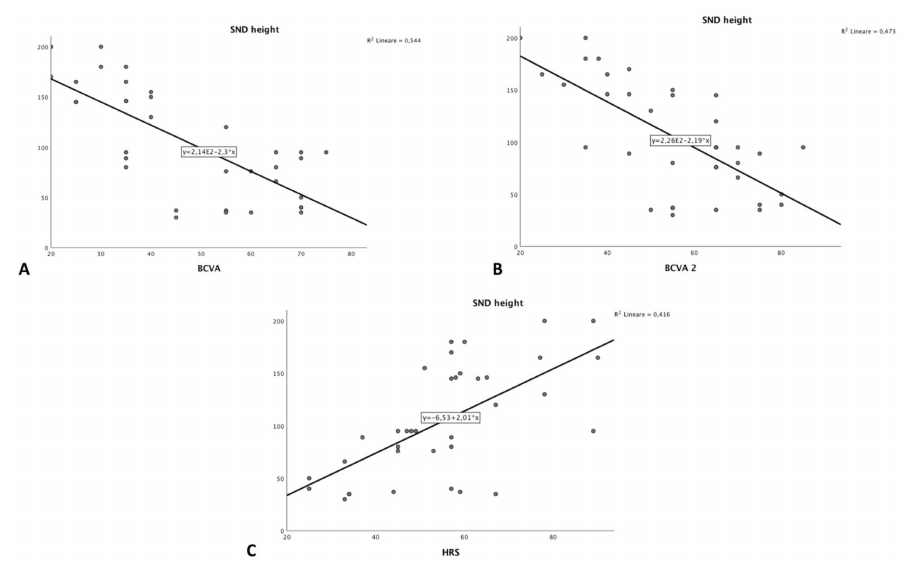
Figure 4. Scatter plot showing the relationship between SDN height and ( A ) BCVA baseline, ( B ) BCVA post-treatment and ( C )